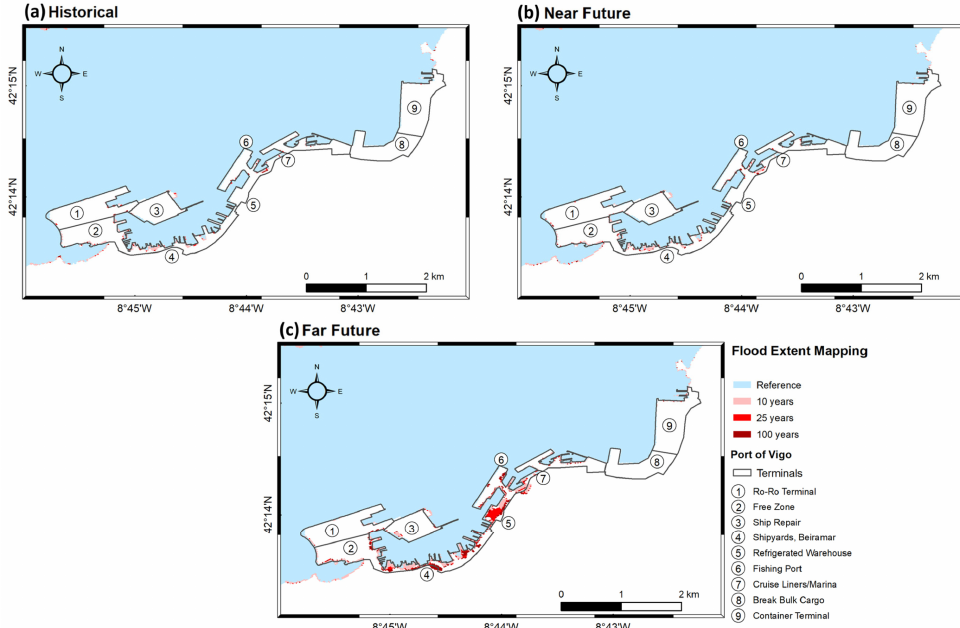
Figure 12. Flood extent mapping of the Vigo port’s terminals (numbers 1–9) located along the Ria de Vigo margins. Reference scenario under the present climate and 10-, 25- and 100-year return periods are determined for the ( a ) historical (1979–2005), ( b ) near future (2026–2045) and ( c ) far future (2081–2100) climate periods.